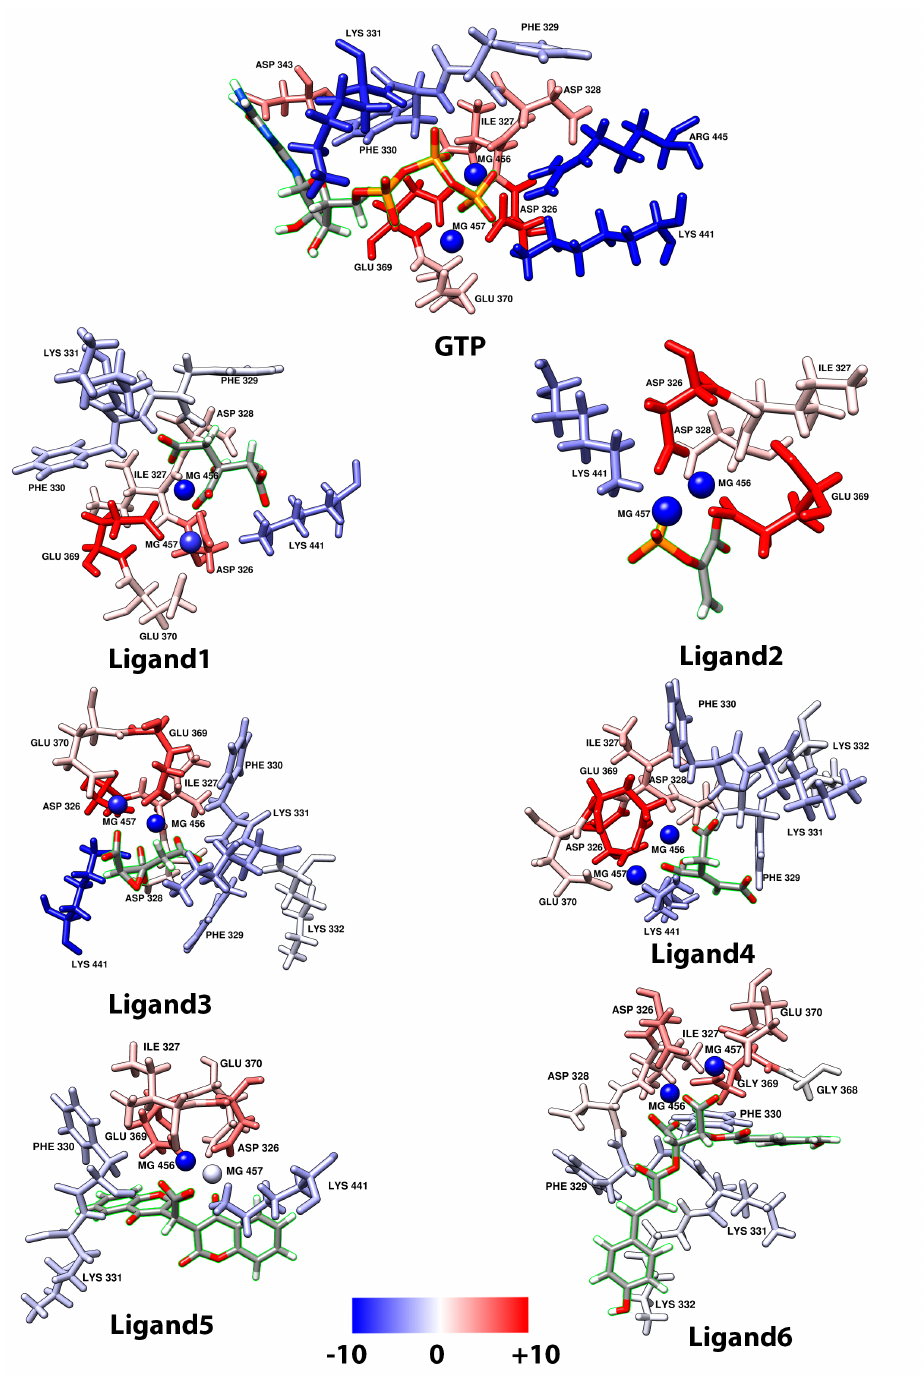
Figure 7. Contribution per residues around 3 Å from ligand in MM/PBSA calculation for each molecule and GTP, blue color indicates favorable interaction, meanwhile red color indicates non-favorable interaction. Ligand is highlighted in